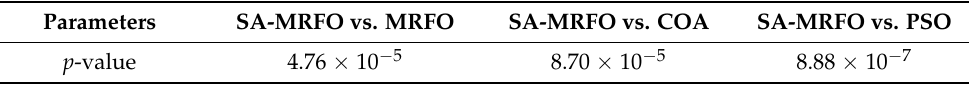
Table 7. p -values obtained with Wilcoxon’s rank-sum test (5% significance